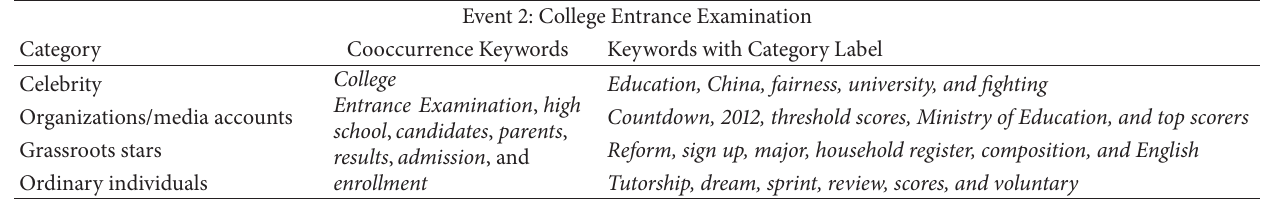
Table 6: Keywords distribution on the event of “College Entrance Examination.”